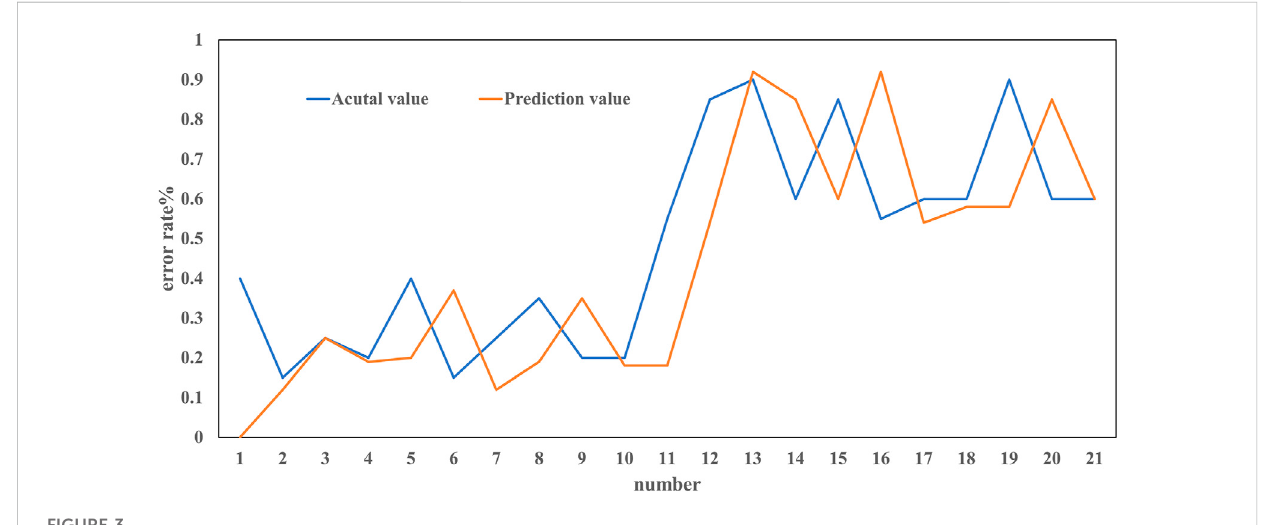
FIGURE 3 Comparison between actual values and predictive value.